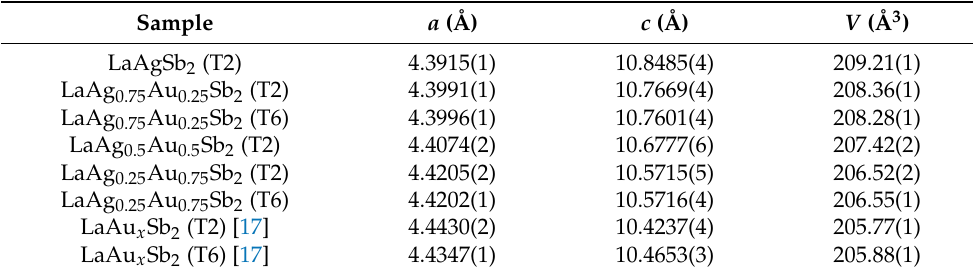
Table A1. Lattice parameters of LaAg 1 − x Au x Sb 2 samples (labels in parentheses indicate initial growth compositions, see Experimental details section for more